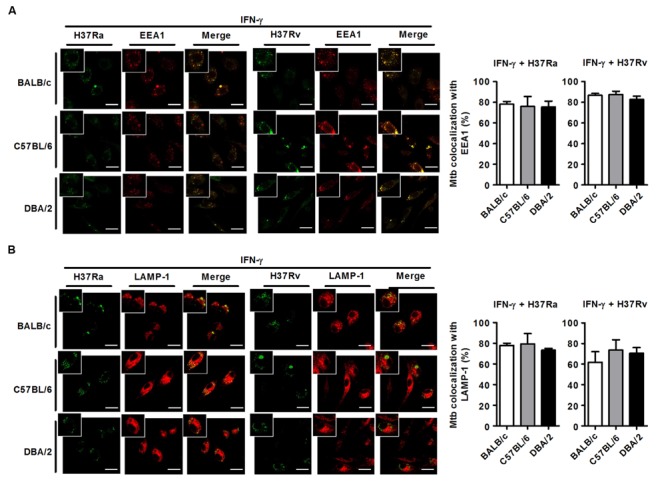
IFN-γ restores phagosome maturation in H37Rv-infected DBA/2 BMDMs. BMDMs were stimulated with IFN-γ (20 ng/ml) for 2 h and then infected with either virulent H37Rv or attenuated H37Ra. After 4 h, the cells were fixed and stained with anti-CD107a LAMP-1-Alexa Fluor® 647 or anti-EEA1-Alexa Fluor® 647 antibodies. Co-localization between M. tuberculosis and EEA1 (A) or LAMP-1 (B) was analyzed using confocal microscopy. The bar graphs show the percentage of M. tuberculosis foci that co-localized with EEA1 (A, top panel) or LAMP-1 (B, bottom panel) in the quantitative analysis. The data are presented as the mean ± standard deviation (n = 10).